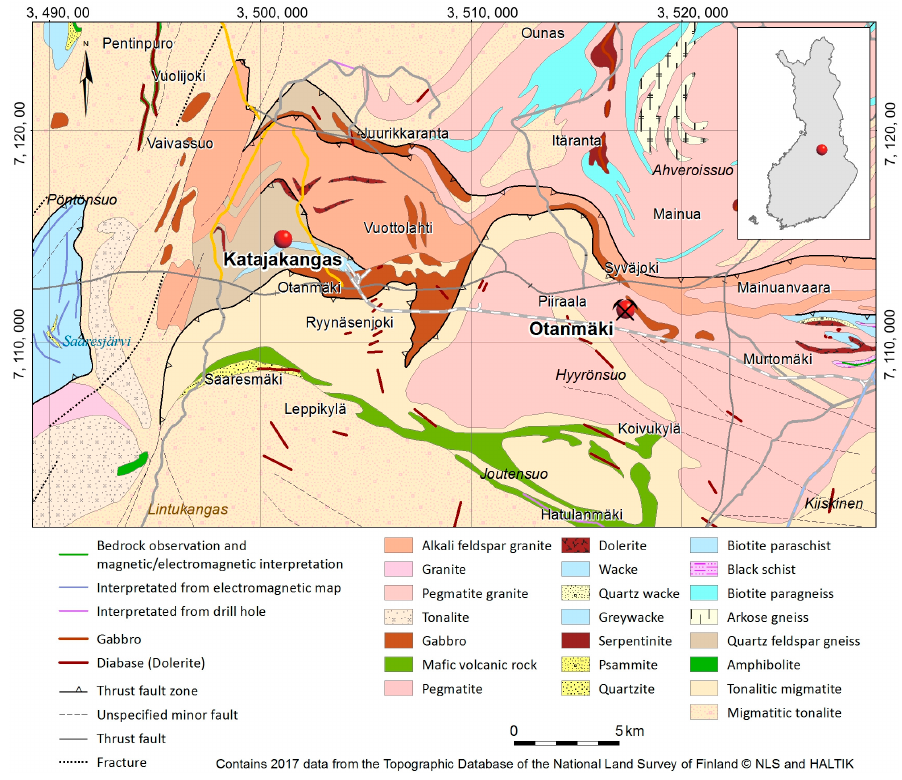
Figure 8. Geology of the Katajakangas and Otanmäki area on the basis of the electronic DigiKP map available at the Geological Survey of Finland. Coordinates correspond to the Finnish National Coordinate System ETRS-TM35FIN.